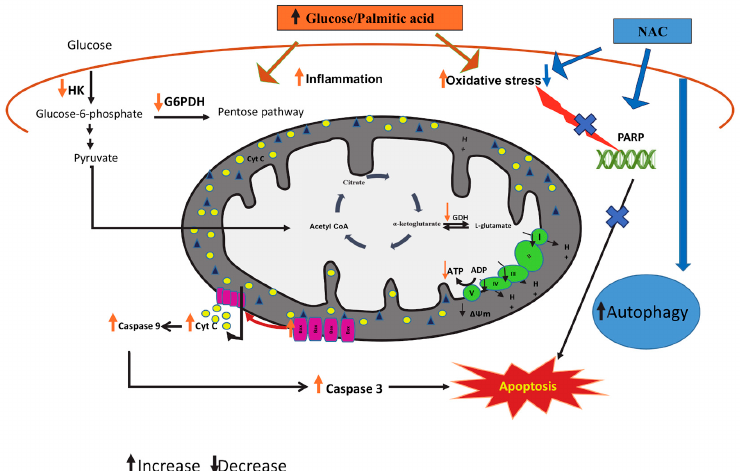
Figure 10. Schematic model representing the cytoprotective mechanisms of NAC in glucolipotoxicity- induced Rin-5F cells. High glucose / high fatty acids have been shown to cause increased oxidative stress, DNA breakdown, and mitochondrial dysfunction, causing activation of caspases and leading to apoptosis. Glucolipotoxicity has also been shown to cause alterations in the expression of autophagy and cell signaling markers. As shown in the model, NAC protects the cells from the glucolipotoxicty-induced mitochondrial and metabolic stress by enhancing autophagy, leading to suppression of apoptosis, thus reducing oxidative stress. GDH: glutamate dehydrogenase, HK: hexokinase, G6PDH; glucose-6-phosphate dehydrogenase, Cyt c; cytochrome